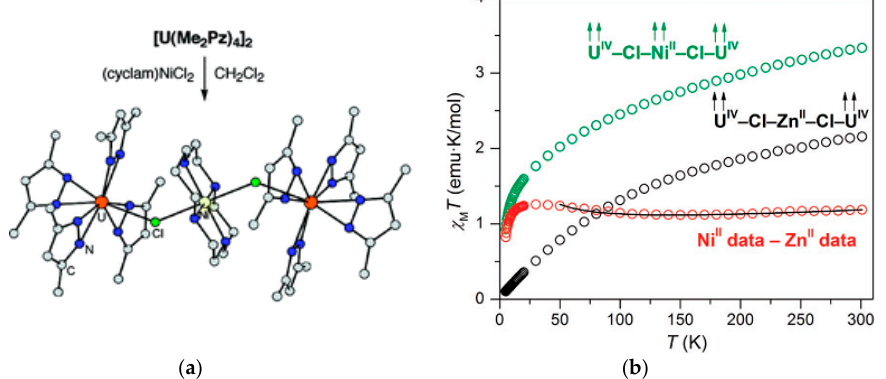
Figure 29. ( a ) Structure of the linear cluster (cyclam)Co II [( µ -Cl)U IV (Me 2 Pz) 4 ] 2 and ( b ) Variable- temperature magnetic susceptibility plot. Orange, purple, green, gray, and blue spheres represent U, Co, Cl, C, and N atoms, respectively. H atoms are omitted for clarity (reprinted with permission from [122], American Chemical Society,